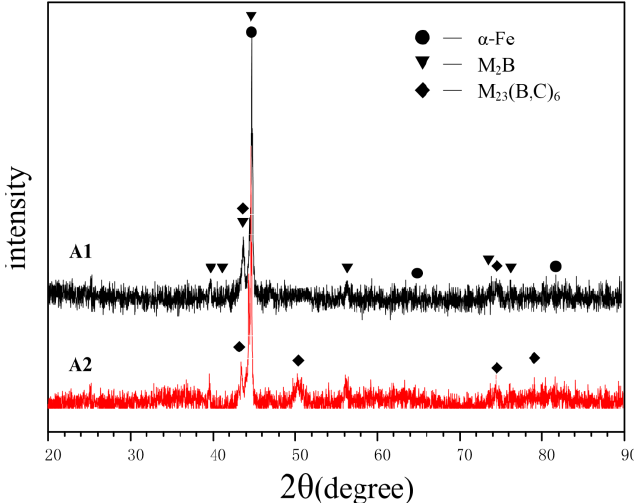
Figure 1. XRD patterns of the as-cast and heat-treated Fe-Cr-B-C alloy.